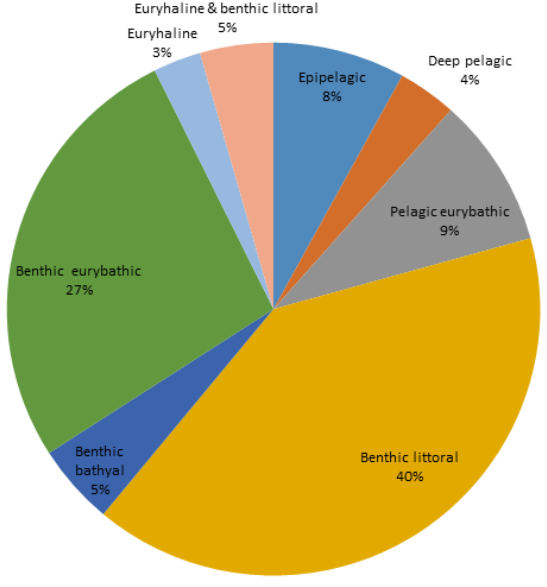
Figure 4. Life environment and depth zonation of fish species recorded in the Adriatic Sea.